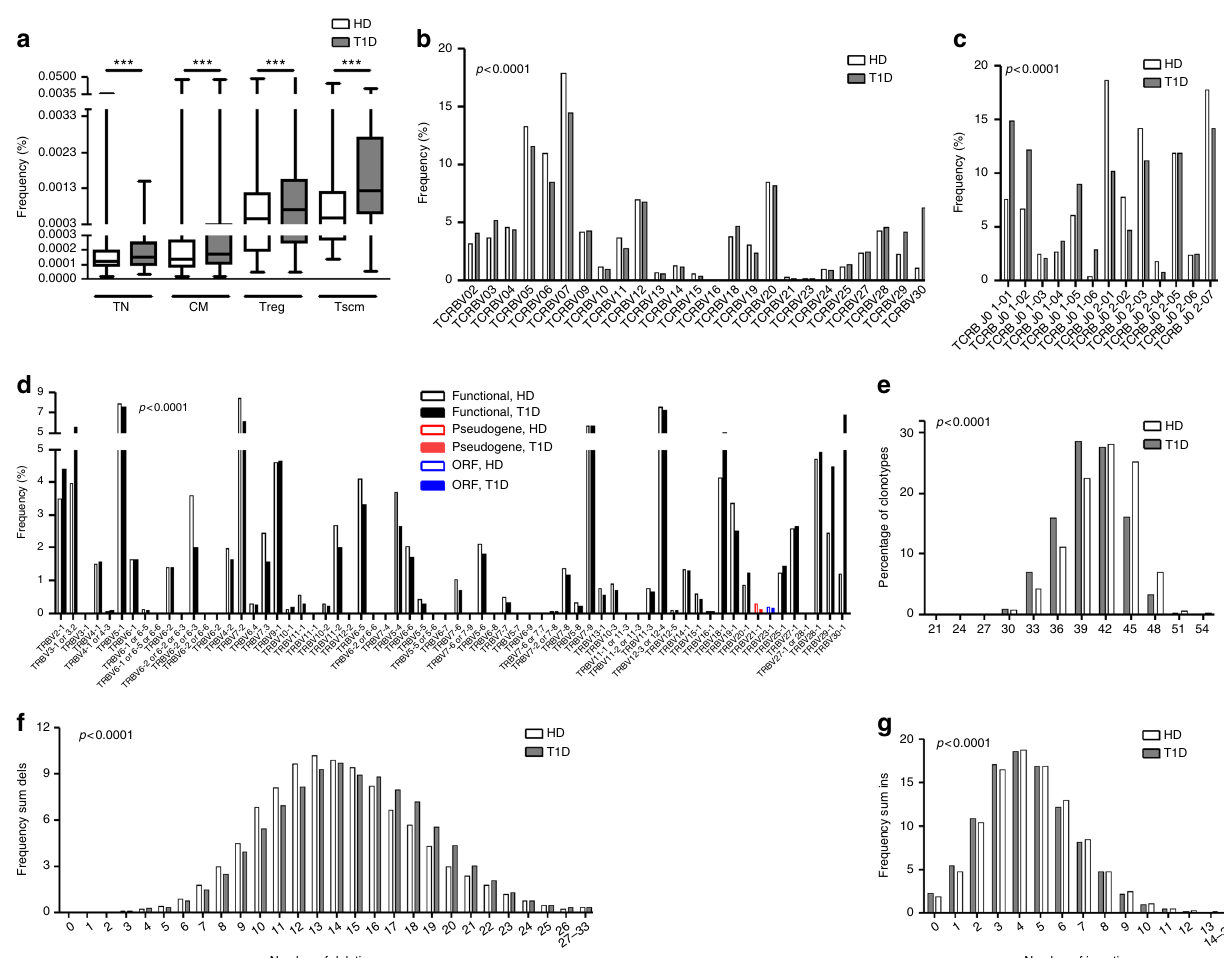
Fig. 7 Type 1 diabetes-enriched clonotypes present an extreme phenotype. a The clonotypes belonging to the type 1 diabetes (T1D)-enriched group are more frequent than the healthy donor (HD)-enriched ones (Mann – Whitney U -test. *** p < 0.001. Lines represent the mean ± SD). b – d T1D-enriched clonotypes show differential usage of V families ( b ), J genes ( c ) and V genes ( d ). e T1D-enriched clonotypes are shorter than the HD-enriched ones. f T1D-enriched clonotypes have more nucleotides deleted (sum of Vdels, D5dels, D3dels and Jdels). g T1D-enriched clonotypes have fewer insertions (sum on n1ins and n2ins). b – g : χ 2